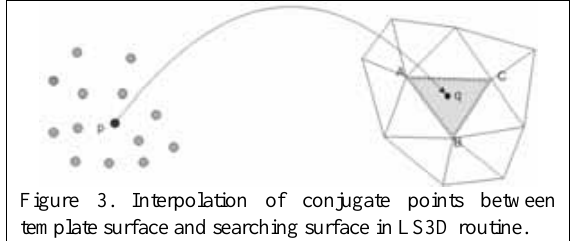
Figure 3. Interpolation of conjugate points between template surface and searching surface in LS3D